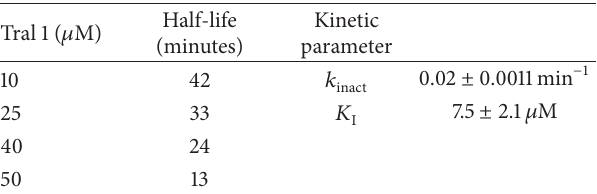
Table 2: Inactivation rates expressed as half-life for the concentra- tion-dependent inactivation.